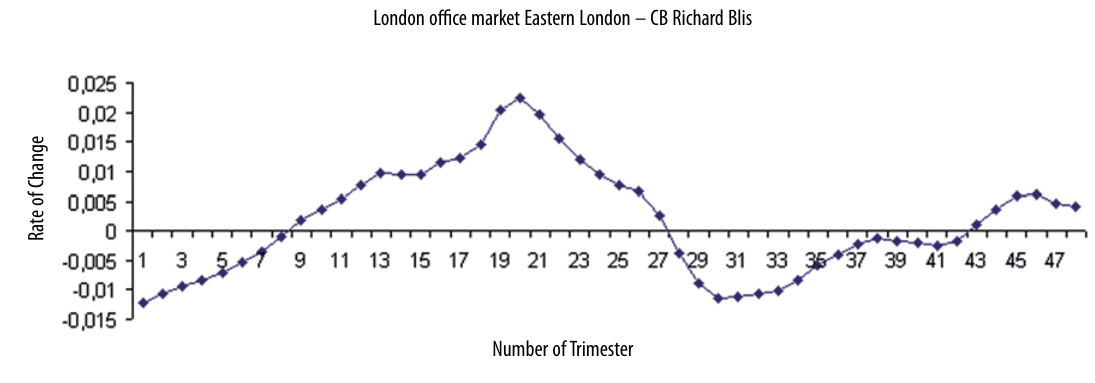
Fig. 5. Prime rent in the London office market in Eastern London the data have been provided by cB richard ellis london